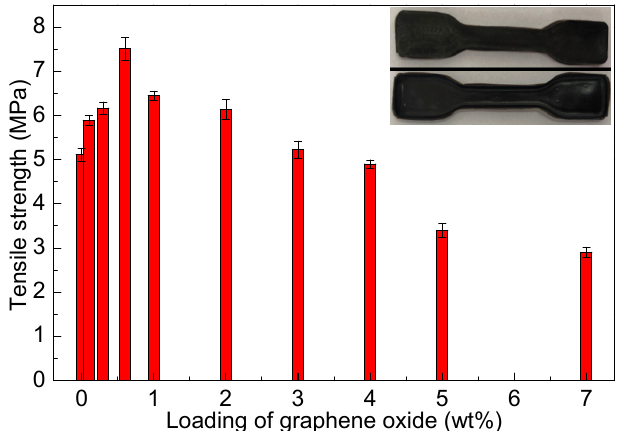
Figure 7. Tensile strength of GO-TPU films with the initial concentrations of TPU of 20 wt % and different loadings of GO. The inserts are the photographs of the tested samples. Error bars in the plots are standard error.